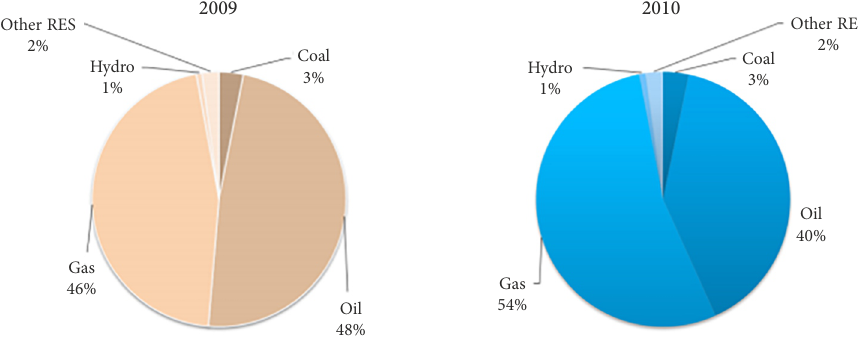
Fig. 1. Total primary energy supply in East Mediterranean Region (OME 2011)